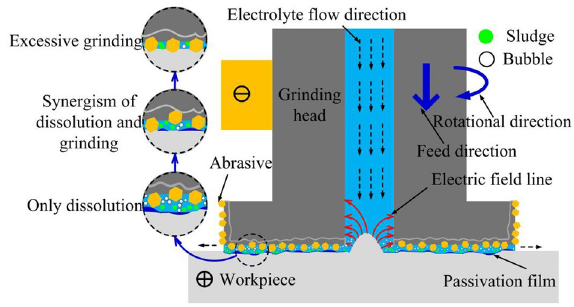
Figure 1. Principle of inner-jet